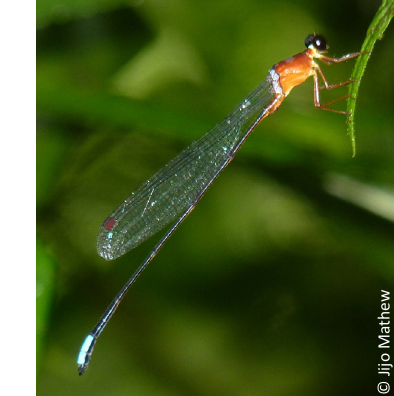
Image 15. Platysticta deccanensis